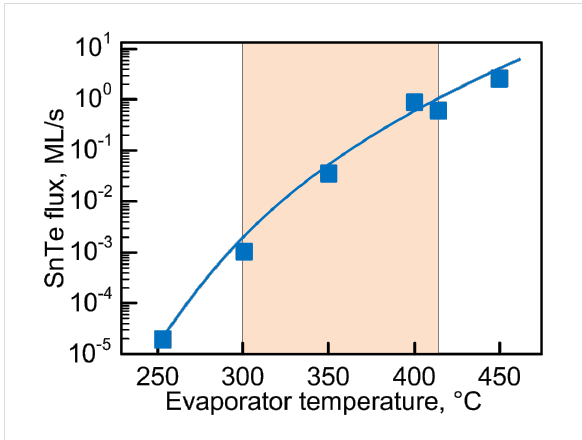
Figure 2: The calibration of the SnTe depositon rate as a function of the evaporator temperature.